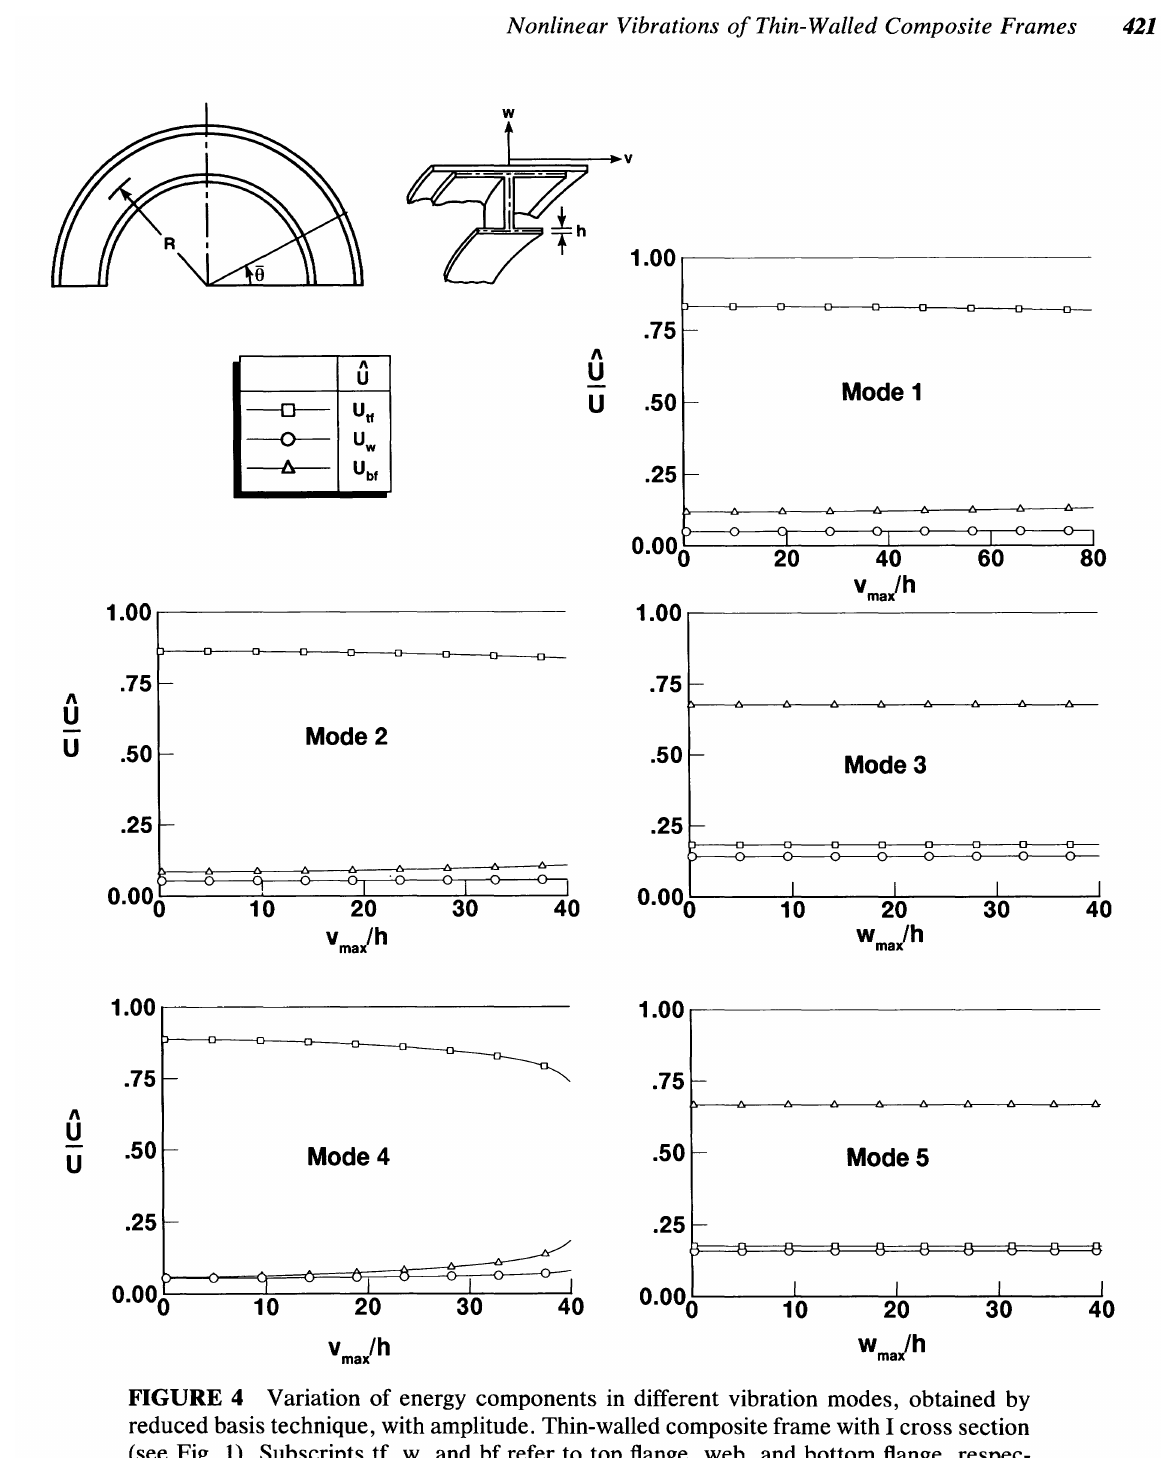
FIGURE 4 Variation of energy components in different vibration modes, obtained by reduced basis technique, with amplitude. Thin-walled composite frame with I cross section (see Fig. 1). Subscripts tf, w, and bf refer to top flange, web, and bottom flange, respec